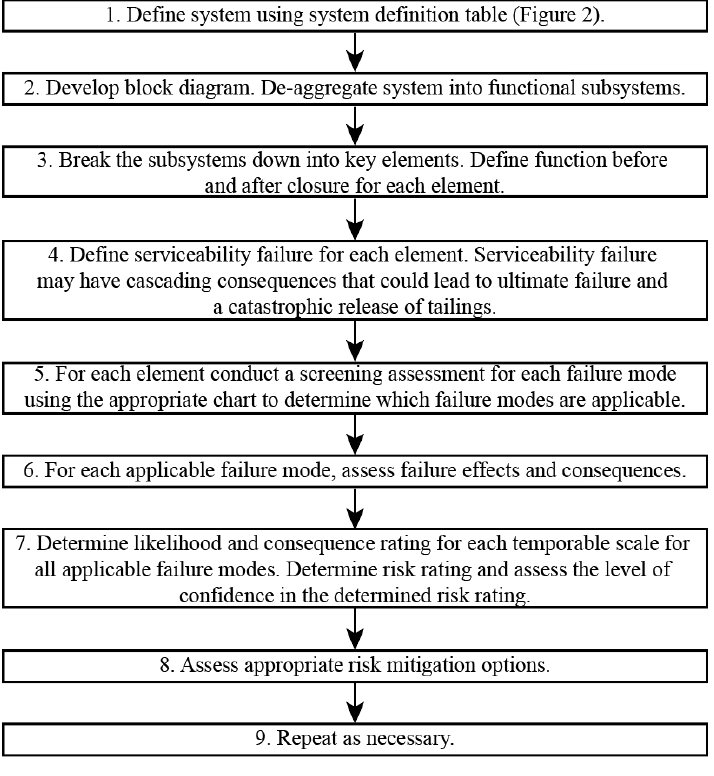
Figure 3. G-FMEA